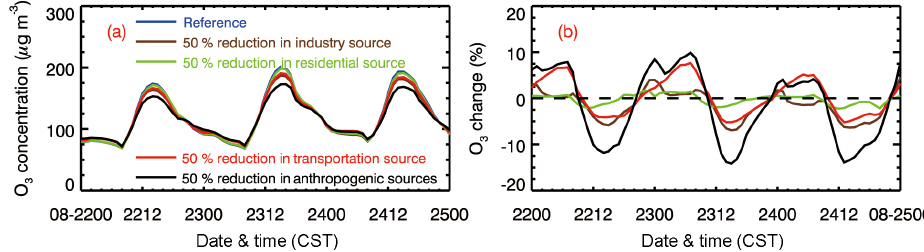
Figure 20. Diurnal profiles of (a) O 3 concentrations and (b) O 3 changes averaged in Xi’an and surrounding areas caused by a 50% reduction in various anthropogenic sources from 22 to 24 August 2013. Blue line: the reference simulation; brown line: the simulation with a 50% reduction in industry emissions; green line: the simulation with a 50% reduction in residential emissions; red line: the simulation with a 50% reduction in transportation emissions; the black line: the simulation with a 50% reduction in all anthropogenic emissions. Table 4. Occurrence days of the defined PM 2 . 5 and O 3 exceedance levels during the summer of 2013. Beijing Tianjin Shijiazhuang Jinan